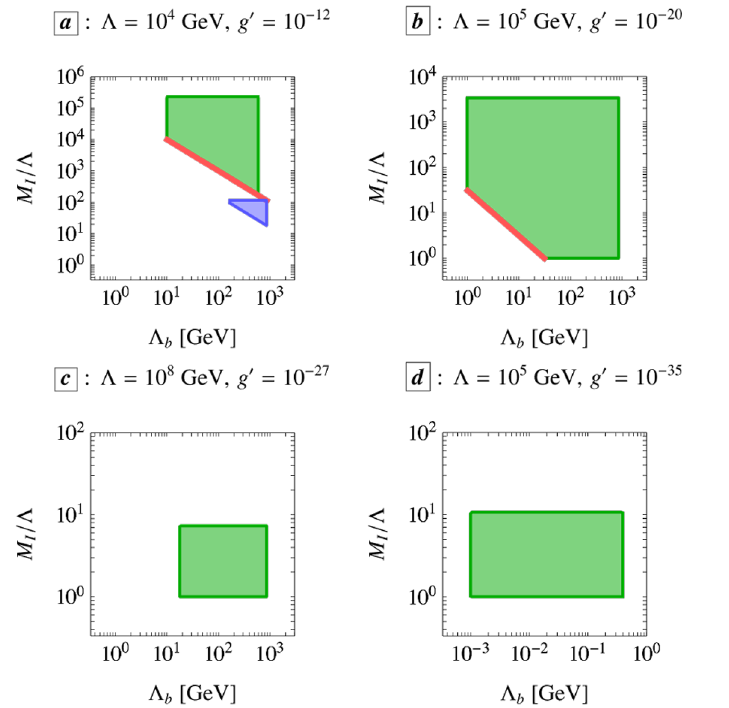
Figure 1 . Same as figure 4 of the paper. Parameter space of the relaxion mechanism taking place with Higgs-dependent barriers, during inflation, where the relaxion is a subdominant component of the energy density of the universe (non-QCD case of ref. [1]), as described in section 3.1 of the paper. In blue the ‘fragmentation’ scenario, in red ‘large barriers’ and in green ‘GKR’. For each benchmark point defined in section 3.1, we show the corresponding distinct regions in the plane Λ b , M I / Λ , in addition to the plots shown in figure 4 of the paper. In the Fragmentation case, the scale of inflation M I is closer to the cut-off Λ than in the other